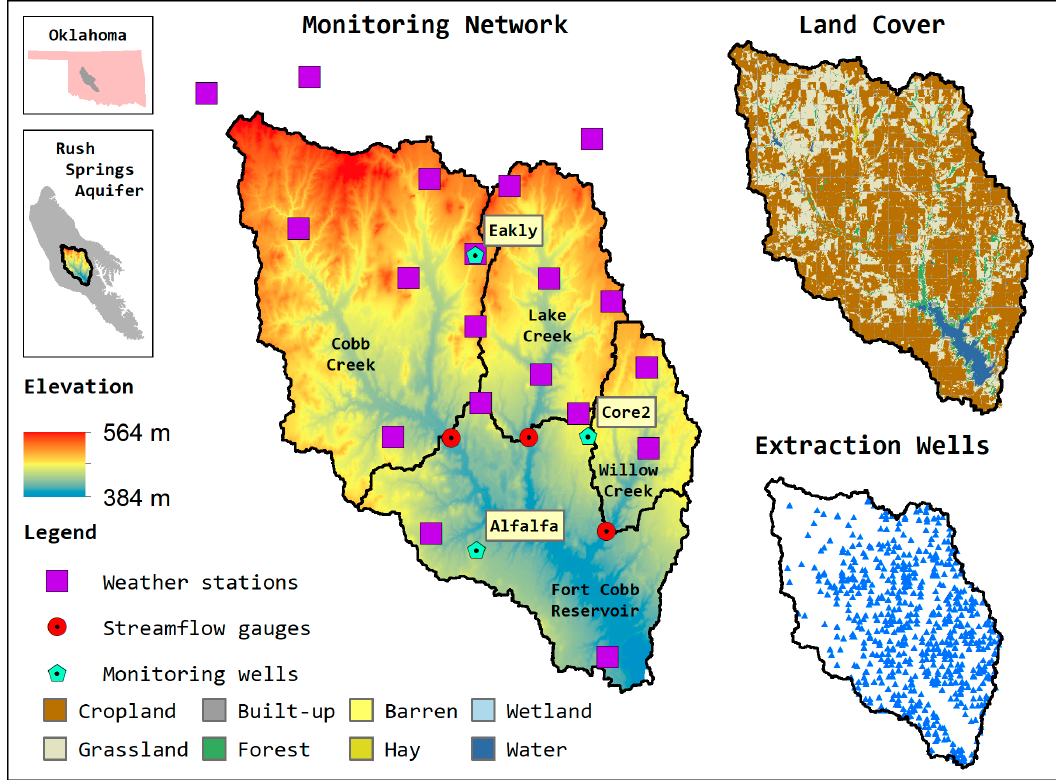
Figure 1. Location and general features of the Fort Cobb Reservoir Experimental Watershed (FCREW) and monitoring network considered in this research.